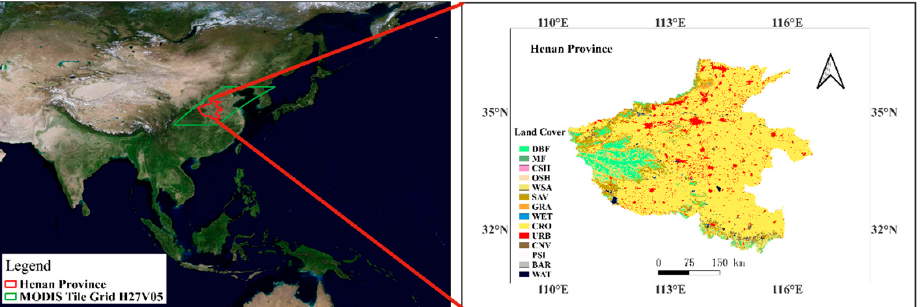
Figure 1. The land cover types of Henan Province. Here, the land cover types are from the MCD12Q1.006 land cover dataset (International Geosphere-Biosphere Programme (IGBP) classification scheme) for the year 2019. The abbreviations are as follows: DBF, Deciduous Broadleaf Forests; MF, Mixed Forests; CSH, Closed Shrublands; OSH, Open Shrublands; WSA, Woody Savannas; SAV, Savannas; GRA, Grasslands; WET, Permanent Wetlands; CRO, Croplands; URB, Urban and Built-up Lands; CNV, Cropland/Natural Vegetation Mosaics; PSI, Permanent Snow and Ice; BAR, Barren; WAT, Water Bodies.